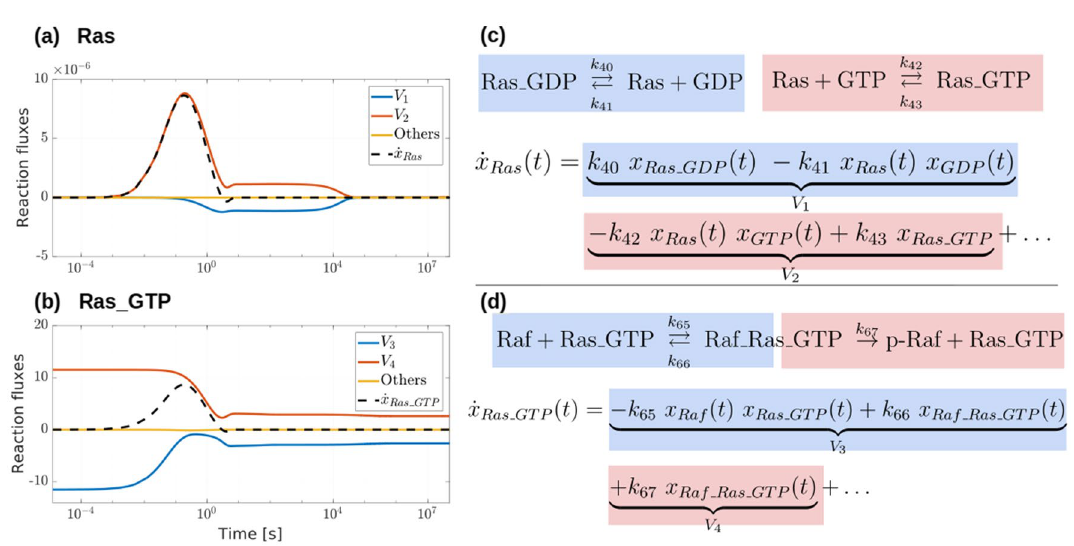
Figure 6. Analysis of the flux rates of the reactions involving Ras and Ras_GTP. ( a , b ) Flux rates that contribute to the dynamics of the concentrations of Ras (inactivated form) and Ras_GTP (the activated form) respectively. ( c , d ) Mathematical expression of the derivatives of such proteins and corresponding chemical